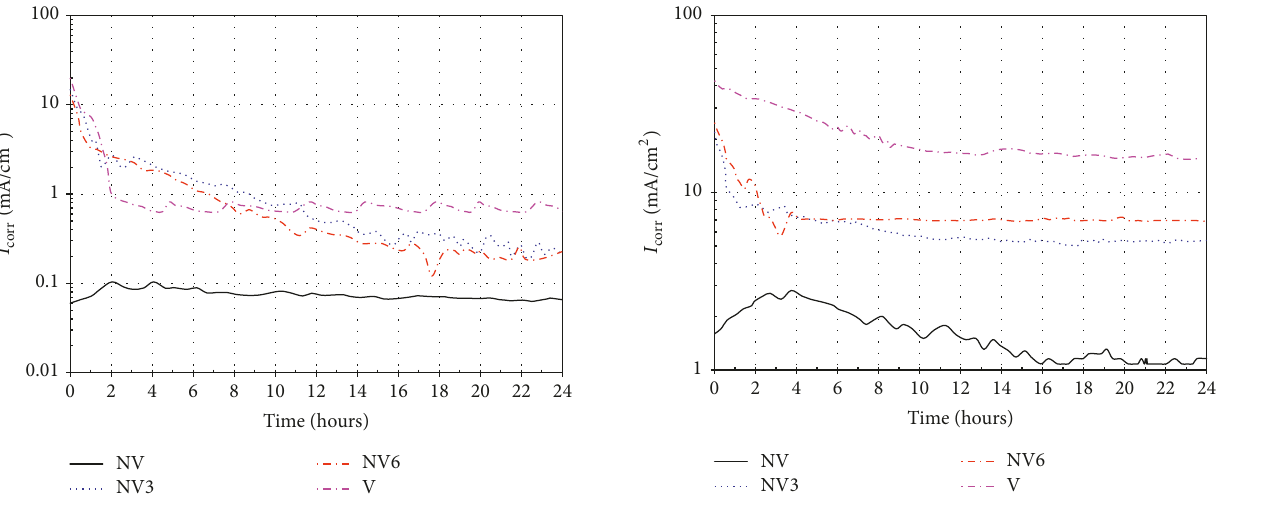
Figure 6: 𝐼 corr variation versus time for Ni in V-rich molten salts at 800 ∘